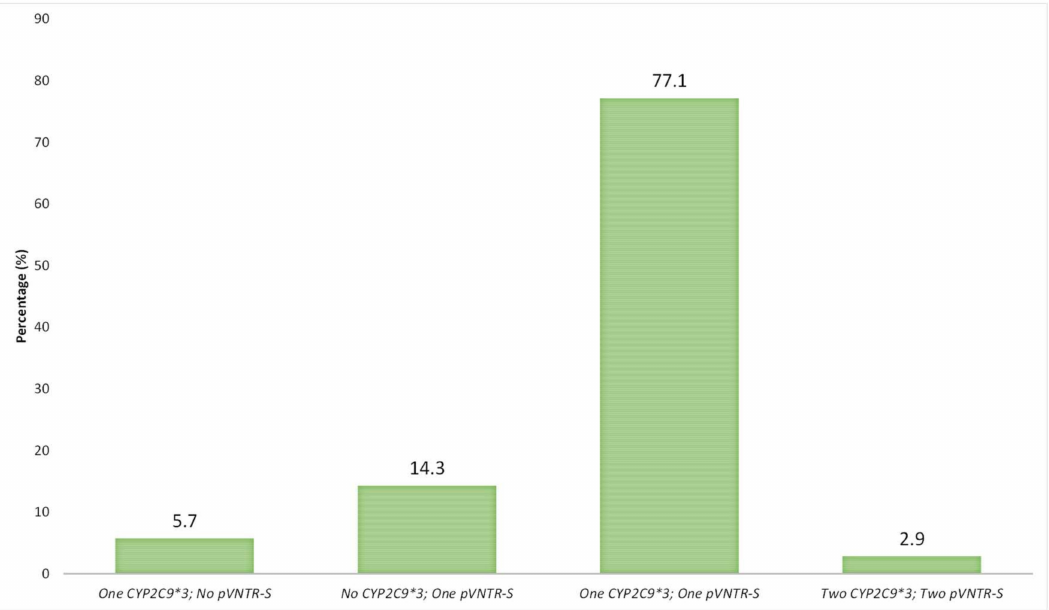
Figure 2. Percentage (%) of individual carriers of zero, one or two pVNTR-S and/or CYP2C9*3 and (n = 35) among Spaniards (n =